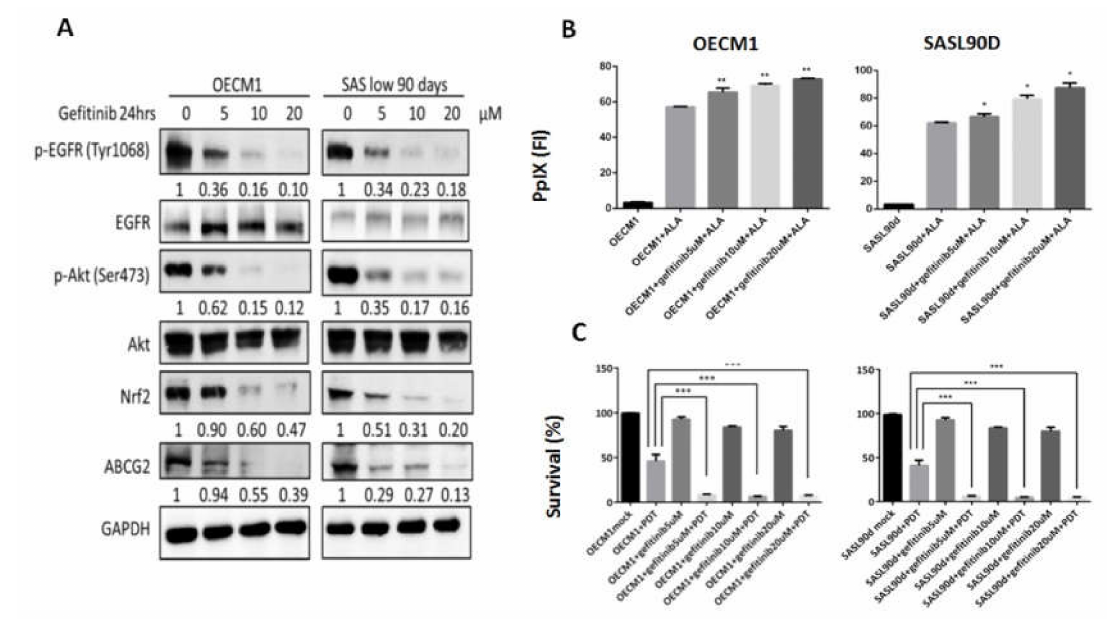
Figure 2. Gefitinib treatment suppresses ABCG2 expression, increases PpIx accumulation, and decreases ALA-PDT-mediated HNC cell viability. ( A ) Western blot analysis for p-EGFR (Y1068), p-Akt (S473), Nrf2, and ABCG2 expression in OECM1 and SASL90d cells treated with di ff erent concentrations of gefitinib. Gefitinib repressed EGFR and Akt signaling activities as well as ABCG2 and Nrf2 expression. In OECM1 and SASL90d, gefitinib treatment ( B ) upregulated PpIX accumulation and ( C ) decreased cell viability in a dose-dependent manner. n ≥ 3; * p < 0.05; ** p < 0.01; *** p <